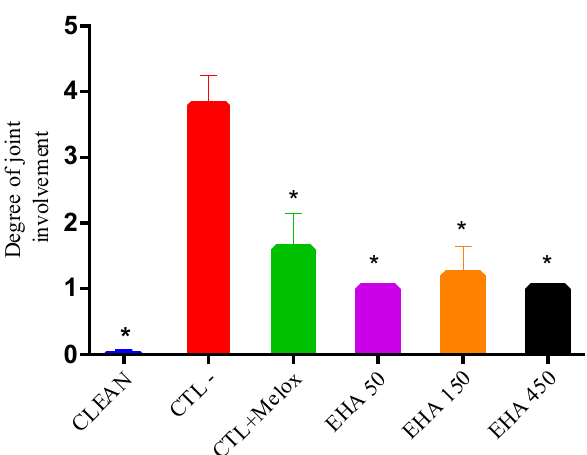
Figure 6. Degree of joint involvement in rats treated with A. chica extract (EHA50, 150, and 450 mg/kg, orally), Meloxicam (CTL + Melox) and saline (CTL–) administered from day 3 after OA induction. This analysis was performed with the knees collected on day 29 after OA induction. The data are represented according to classification proposed by Kellgren–Lawrence. * represents significant differences, with p < 0.05, between the groups treated with A. chica extract and the saline group (CTL − ).